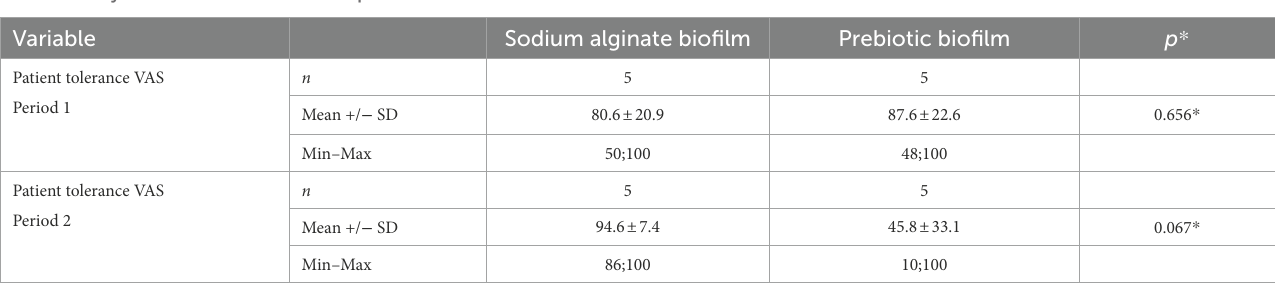
TABLE 3 Analysis of tolerance over the two periods.